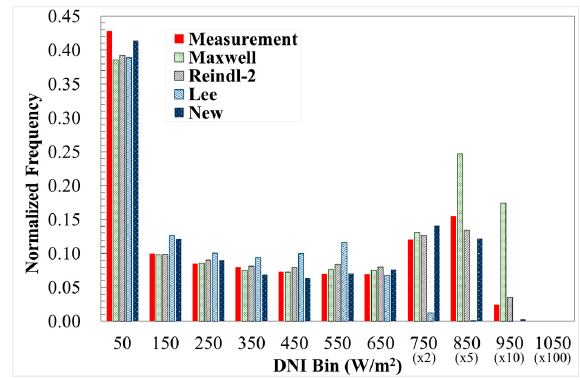
Figure 2. Histograms of DNI measurement and estimation, in which frequency is normalized by dividing by the total number of data points.